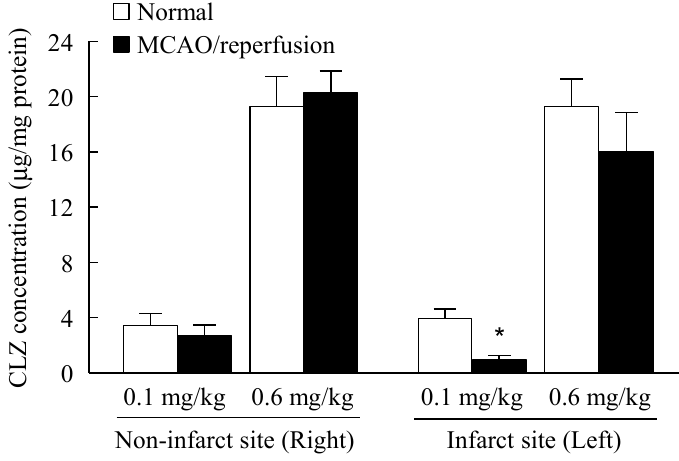
Figure 7. CLZ concentration in the brains of normal and MCAO/reperfusion mice treated with dispersions containing CLZ nanoparticles. MCAO was induced by inserting a silicone-coated 8-0 nylon monofilament into the left middle cerebral artery. Two hours after this procedure, the middle cerebral artery blood flow was restored by withdrawing the nylon monofilament. At 3 h after reperfusion, 0.1 or 0.6 mg/kg CLZ nano dispersion was injected into the tail vein. Three days after the injection, the brains were removed, and cut 1 mm anterior and 1 mm posterior to the center of the bregma. The sliced brain tissue was divided at the center, and CLZ concentrations in the right (non-infarct site) and left (infarct site) parts were measured. The data are presented as means ± S.E. of seven independent rats. * p < 0.05, vs. normal mice for each category.